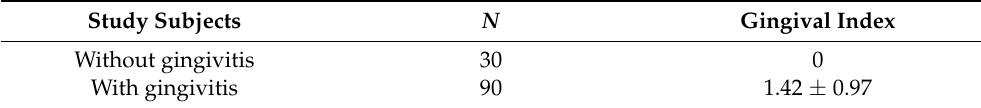
Table 2. The value of the gingival index in subjects with and without gingivitis. Study Subjects N Gingival Index Without gingivitis 30 0 With gingivitis